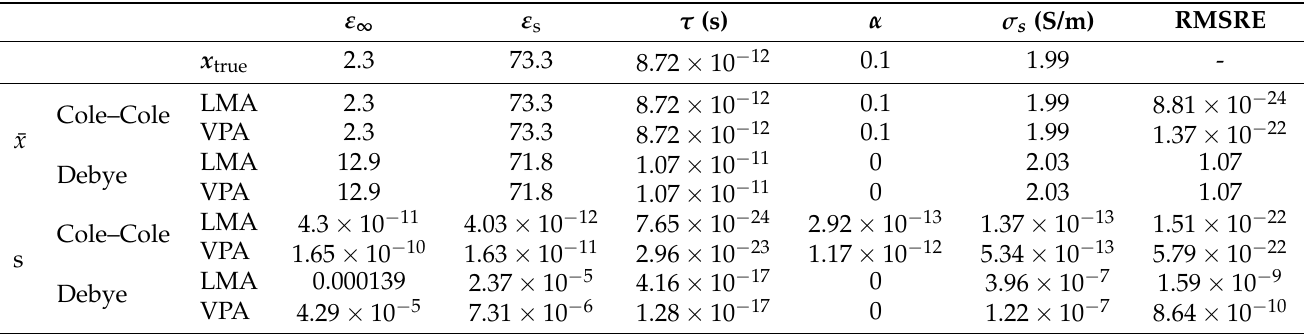
Table 3. Statistical diagnostics on fitting results. Set B of the initial points and 100 mg/dL glucose concentrations were considered.